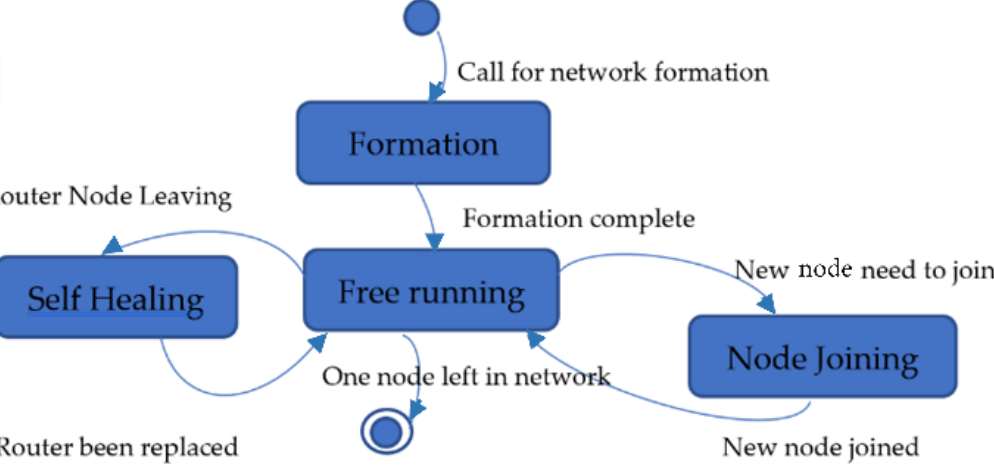
Figure 2. State machine of vehicular grouping approach.